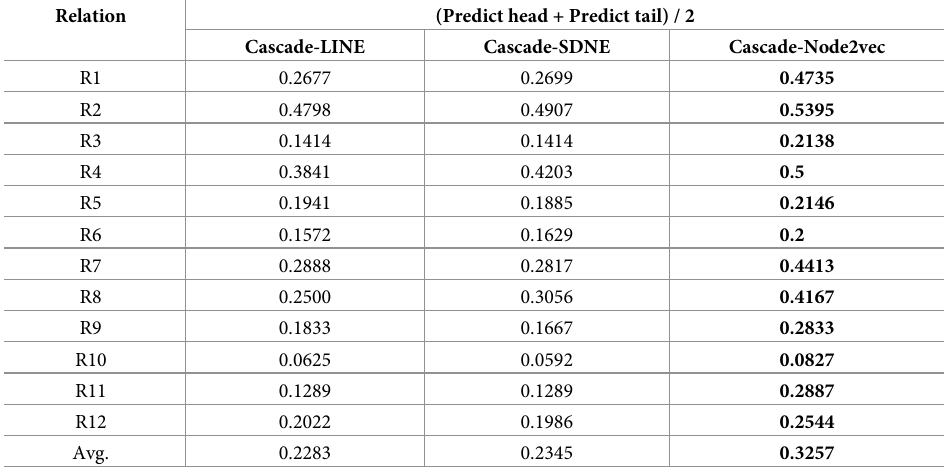
Table 6. Entity prediction based on settings of different graph embedding algorithms (hits@10).